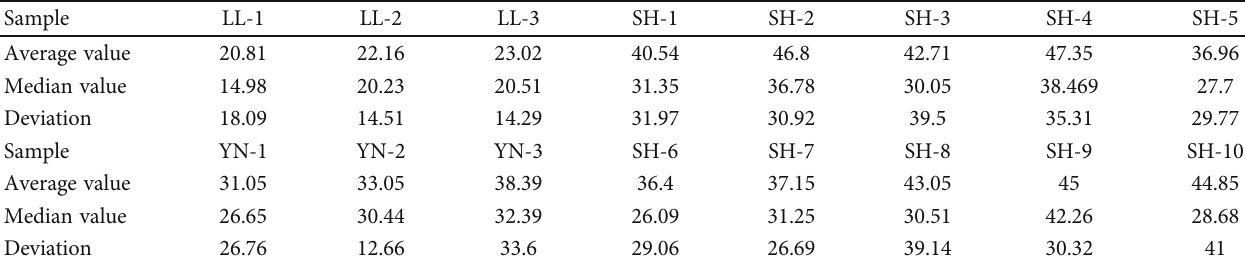
Table 2: Statistical analysis results of particle